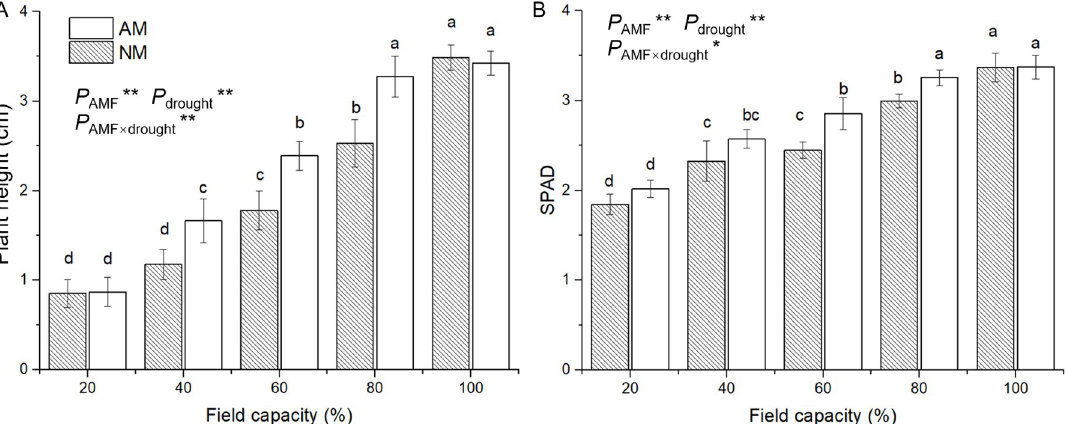
Fig 3. Effect of AM inoculation on plant height (A) and SPAD (B) of E . maackii under water deficit. AM inoculated treatment; NM: uninoculated treatment; AMF: effect of AM inoculation; drought: effect of water deficit; AMF × drought: effect of interaction of AM inoculation and water deficit treatment; � : P � 0.05; �� : P � 0.01. Means with a letter in common within each variable can’t be considered different at P �